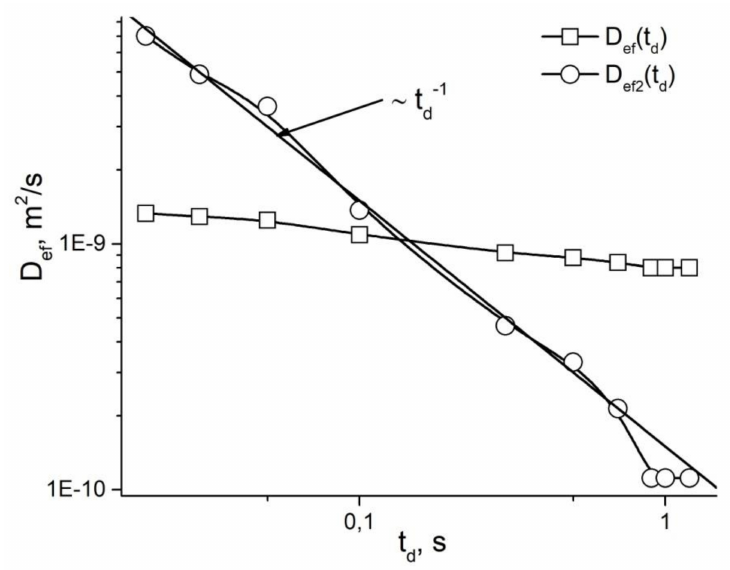
Figure 21. The dependence of the effective diffusion coefficient on the diffusion time for intact seedling roots (solid squares) and the result of the renormalization of D ef ( t d ) into the dependence D ef2 ( t d ) as a function of t d − 1